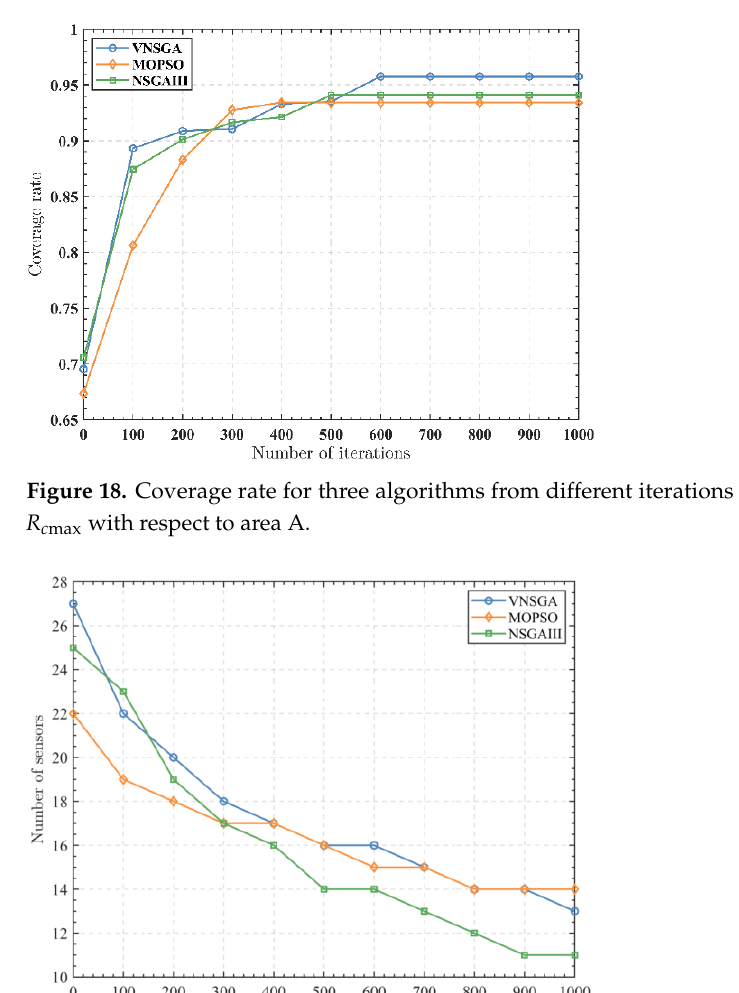
Figure 17. Coverage rate for three algorithms from different iterations for 75 m R smax and 150 m R cmax with respect to area A.